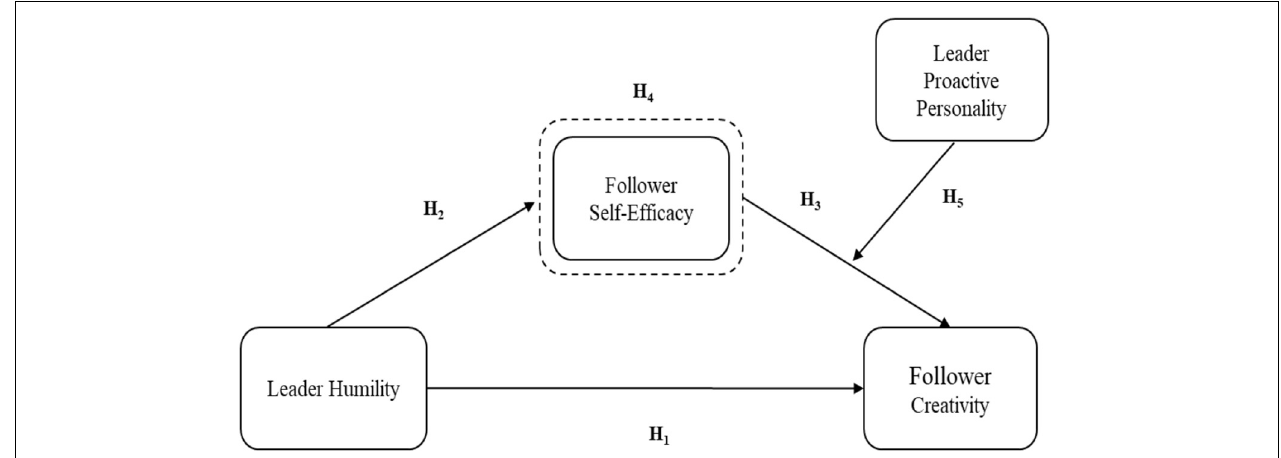
FIGURE 1 | Theoretical framework. Dotted box represent the mediating